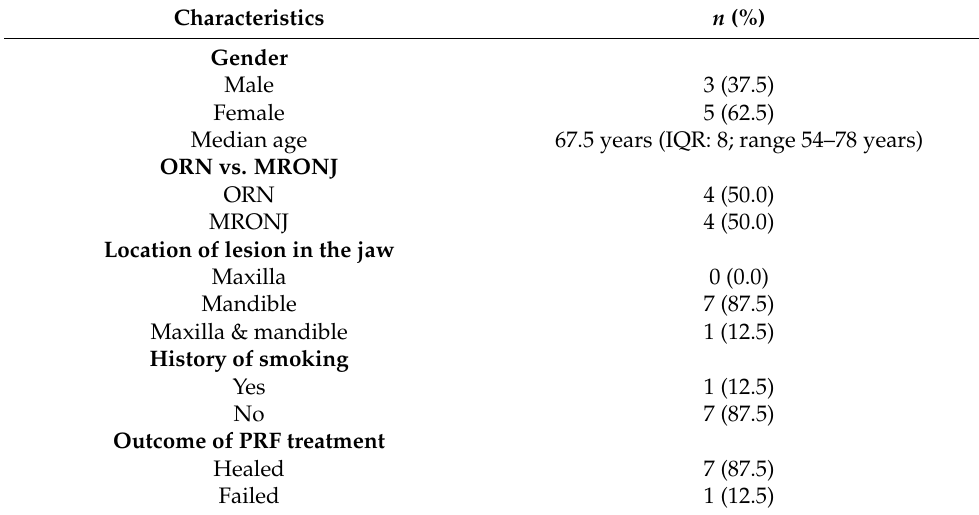
Table 1. Characteristics of patients who had PRF following surgery in the jaw bones.